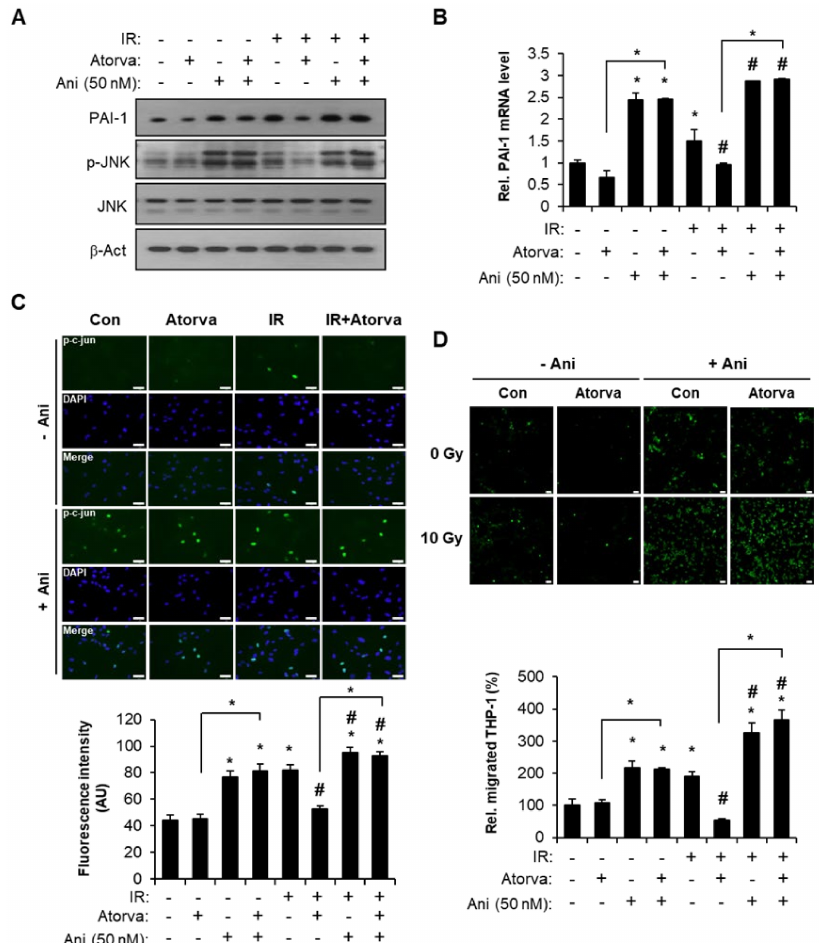
Figure 4. Inactivation of the JNK pathway by atorvastatin regulates PAI-1 production and monocyte migration. ( A ) Western blot analysis of PAI-1 expression and JNK activation in control (Con), atorvastatin-treated (Atorva), irradiated (IR), and IR + Atorva HUVECs in the presence or absence of anisomycin (Ani, 50 nM). ( B ) mRNA levels of PAI-1 and ( C ) immunofluorescence images and the fluorescence intensity of phosphorylated c-Jun (green) in Con, Atorva, IR, and IR + Atorva HUVECs in the presence or absence of Ani. ( D ) Trans-endothelial migration of THP-1 cells in atorvastatin-treated irradiated HUVECs. Representative images of migrated carbosyfluorescein diacetate succinimidyl ester (CFSE)-stained THP-1 cells (green). The number of migrated THP-1 cells was quantified and plotted (lower). Data are presented as the mean of ± standard deviation of triplicate experiments. Images are representative of 3 independent experiments. * p < 0.05